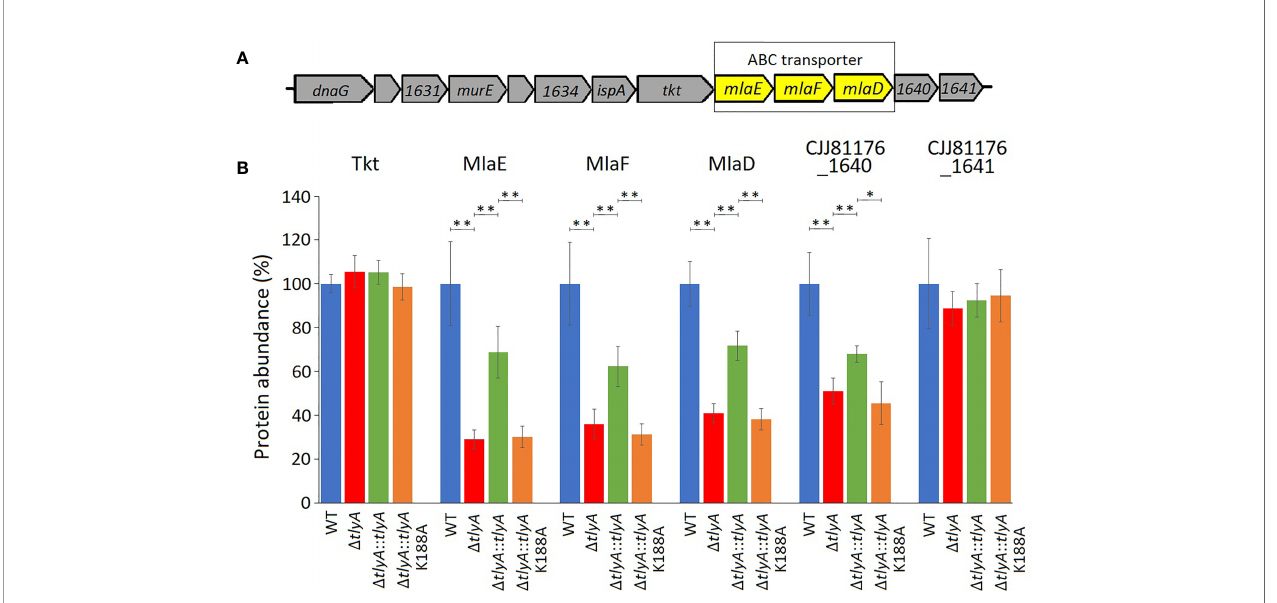
FIGURE 2 | Changes in abundances in the proteins encoded within and adjacent to the C. jejuni mlaEFD operon upon inactivation of tlyA (color-coded as in Figure 1 ). (A) Organization of the C. jejuni mlaEFD gene cluster. The strain-speci fi c notations for these genes are given in Table 3 . (B) The abundance of each of the MlaE, MlaF and MlaD proteins is dependent on a functional C. jejuni tlyA gene **P < 0.001 (strain notation as in Figure 1 ). The abundances of the upstream- encoded protein Tkt remained unchanged. However, expression of the downstream-encoded protein CJJ81176_1640 ( Table 2 , and hereafter referred to as CJ1640) was consistently reduced, *P < 0.05, (but outside our cut-off criteria), while its CJ1641 neighbor was unchanged. These three additional proteins are shown here for comparison. The error bars represent standard deviations from three biological